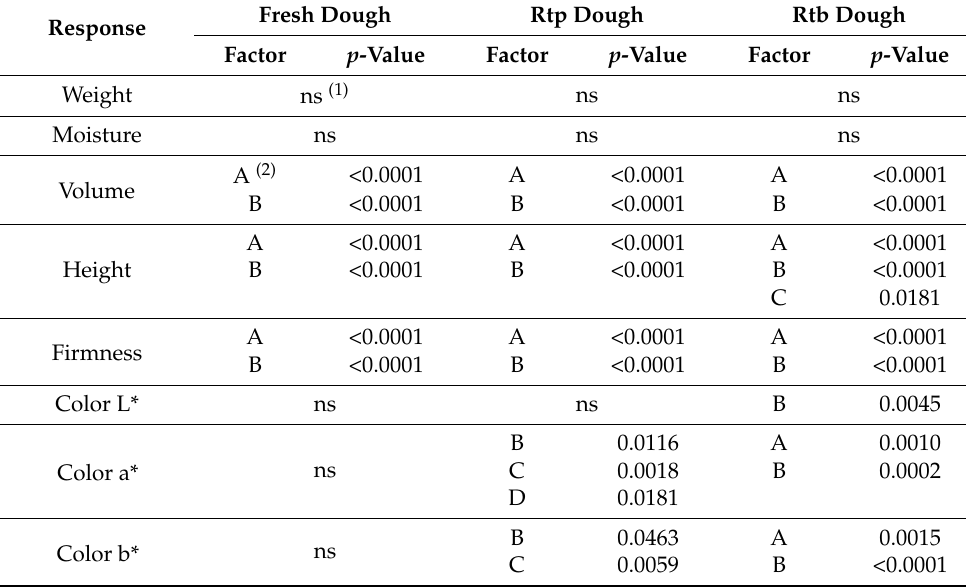
Table 3. Significant factors and p -values for quality characteristics of bread made with the fresh dough and with the RTP and RTB dough by ANOVA ( p <